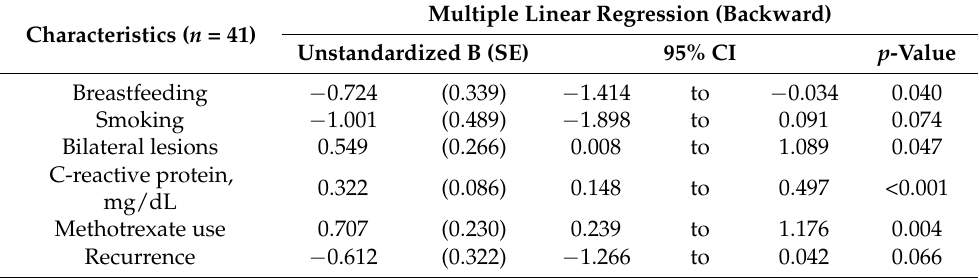
Table 4. Backward multiple linear regression model for prediction of time to resolution in patients with idiopathic granulomatous